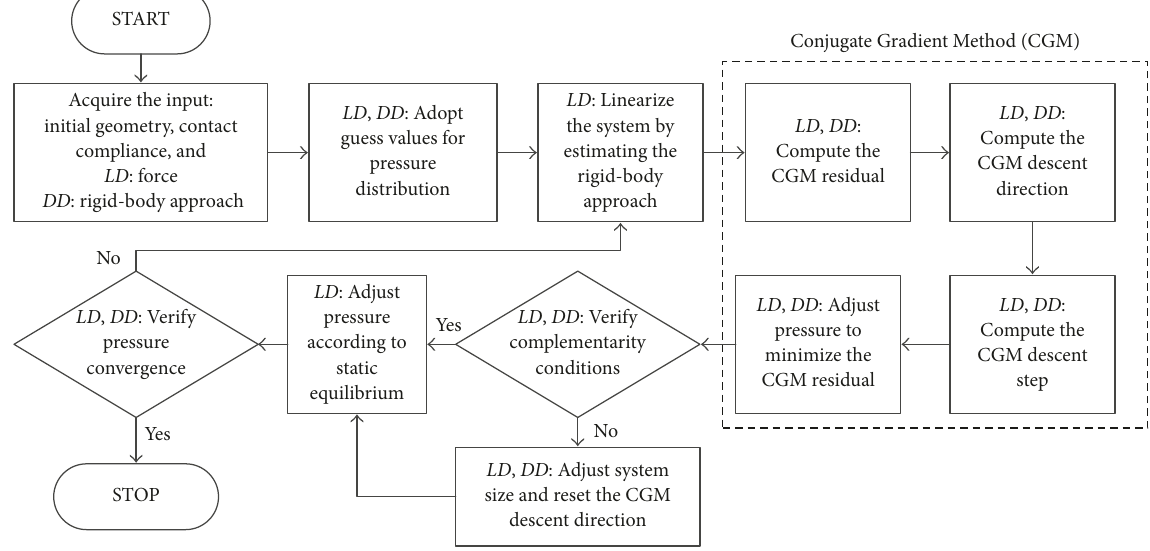
Figure 2: Generalized algorithm flowchart for the instantaneous (i.e., with 𝑘 fixed but arbitrary) contact state.